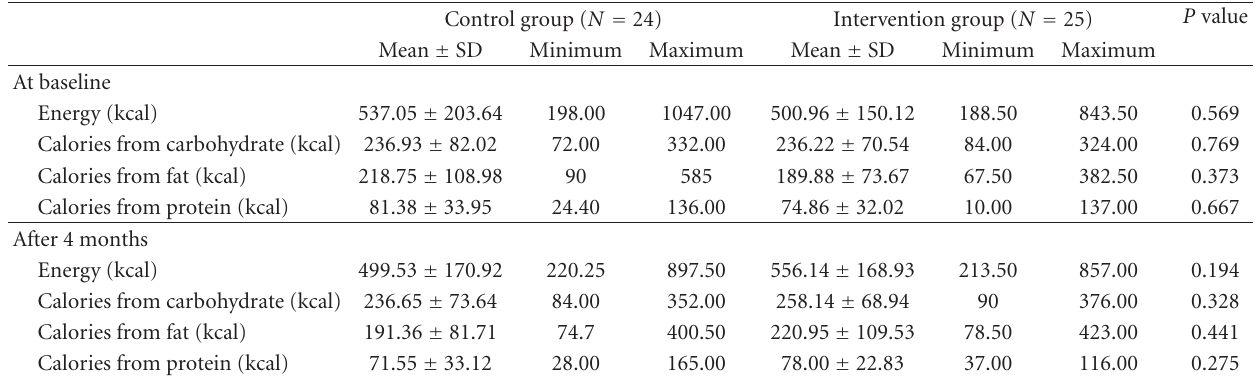
Table 3: Diet-recalled menu for lunch of participants.